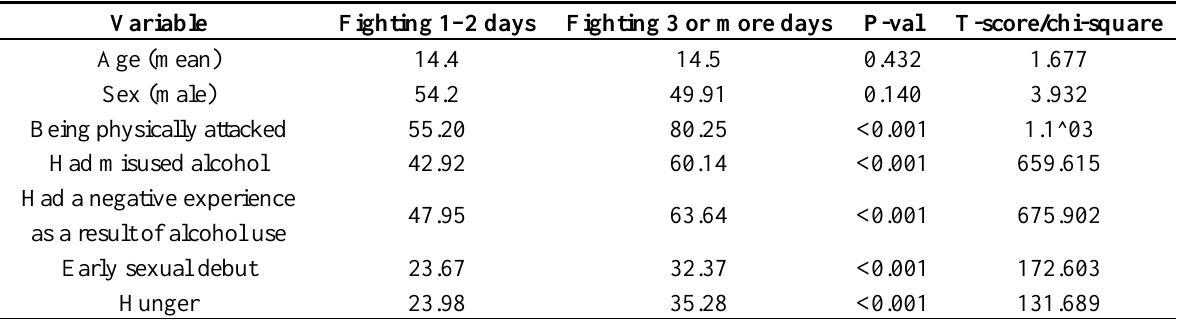
Table 1. Differences among school-attending adolescents who reported being involved in physical fights in Ghana